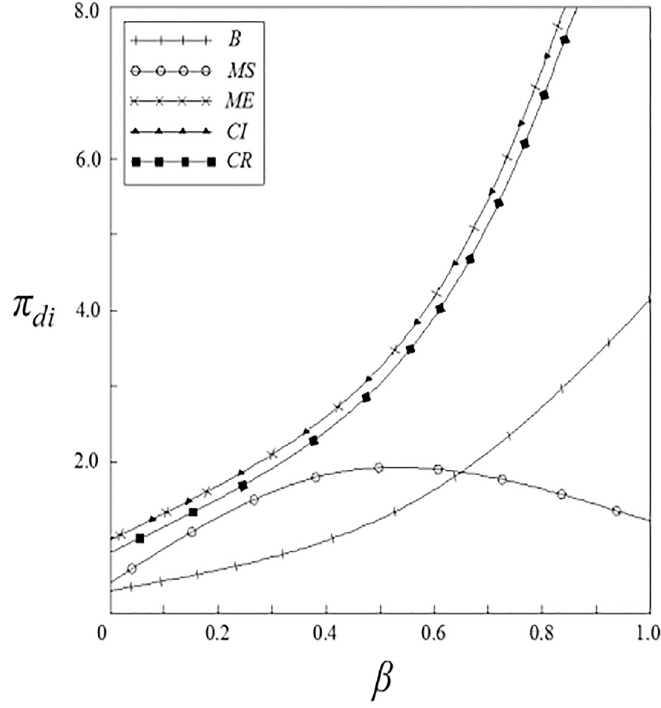
Fig 14. The relationship between π di and β .